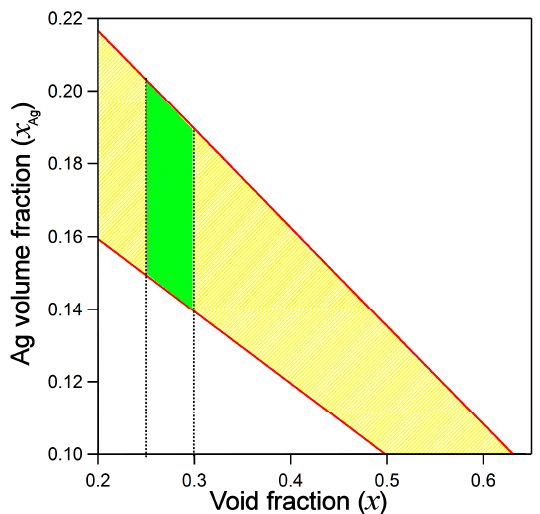
Figure 5. boundary values for void factor x (porosity) and x Ag (volumetric fraction of Ag) are shown: allowed values lie in the yellow region of the graph, green area represents the value range for both x and x Ag where fit of the ellipsometric data shows a minimum square error MSE < 10. A meaningful model of SE data has to cope with topography data of AFM (40 nm height and surface roughness < 3 nm) and boundaries set by film chemical composition, as discussed above. Our model is more likely to give only a confidence band for the film porosity rather than a precise assessment: different trials were performed and best fit (mean square error MSE < 10) is obtained for x = 25 ± 5% porosity and volumetric silver fraction x Ag = 18.5 ± 0.5%. In Figure 4b we propose the best fit model for the Ag/Ti 50/50 nanocomposite film using Drude oscillator corrected with NP size effect (FPE) on dielectric function. The inferred thickness is 43 ± 1.7 nm and surface roughness 2 ± 0.4 nm, in good match with AFM measurements, x Ag = 18.4 ± 0.7% and void factor x = 25 ± 5%, compatible with the limits set in Equation (6): these values fall into the green colored best fit region in Figure 5.